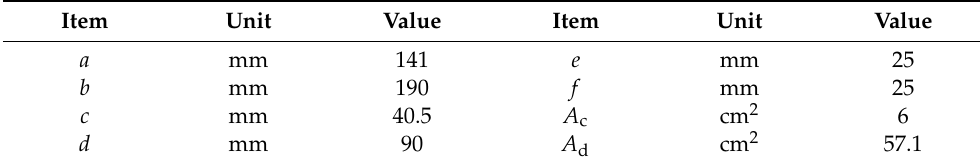
Table 2. Structure parameters of C-type Fe-based nanocrystalline iron core.